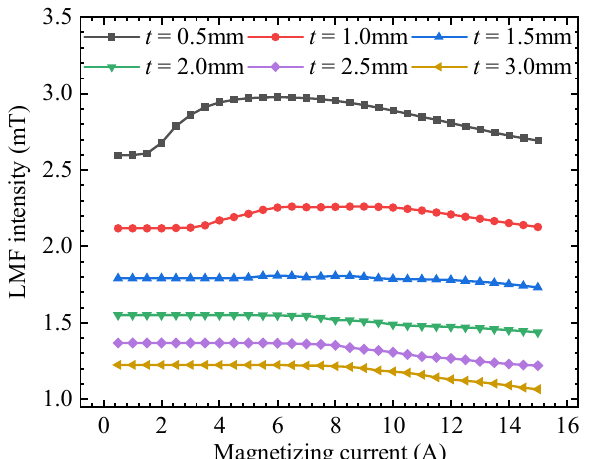
Figure 4. The relationship between the intensity of the defect LMF and the magnetizing current under different plate thicknesses t .